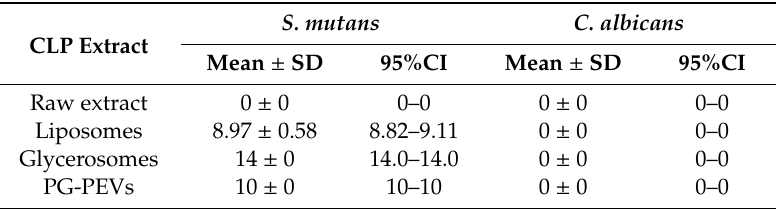
Table 5. Descriptive statistics for the antimicrobial activity of CLP extract against the microorganisms using the Disc Di ff usion